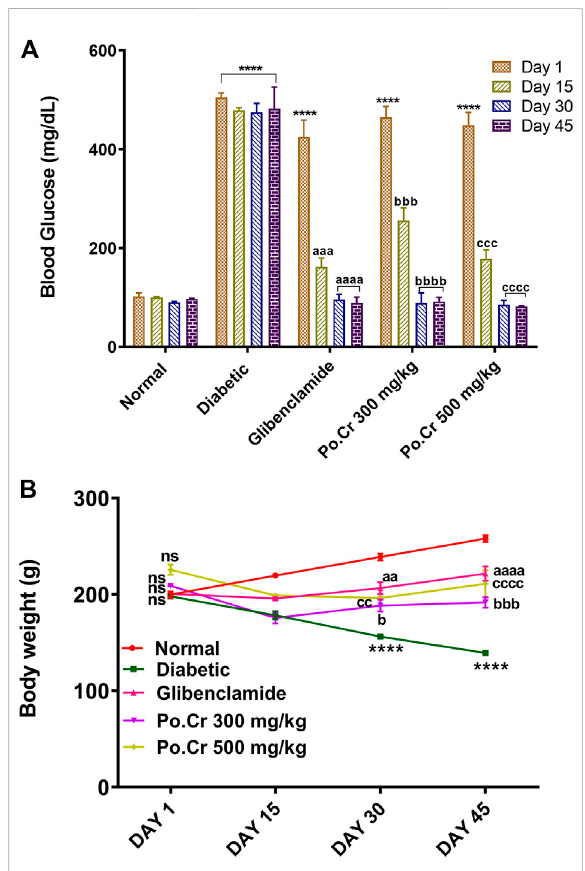
FIGURE 1 Graphical representation of the effects of methanolic extract of Plumeria obtusa L. on (A) blood glucose levels (mg/dl) and (B) body weight of rats. Group II (diabetic control) was compared to Group I (normal control), whereas all the treated groups (Groups III [glibenclamide] to V [Po.Cr]) were compared with Group II. ANOVA (two-way) and the multiple comparison Dunnett ’ s test were applied, and the data values are mean ± SEM. * p < 0.05 shows comparison of the diabetic control (Group II) to thenormal control (Group I), whereas a p < 0.05, b p < 0.05, and c p < 0.05 indicate comparison of glibenclamide (Group III); Po.Cr, 300 mg/kg (Group IV); and Po.Cr, 500 mg/kg (Group V) versus the diabetic control group,